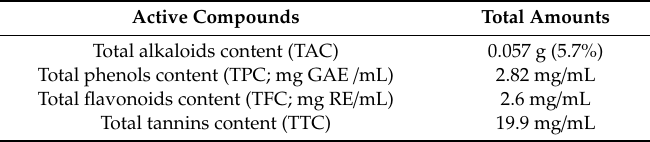
GAE: Gallic Acid Equivalents; RE: Rutin Equivalents